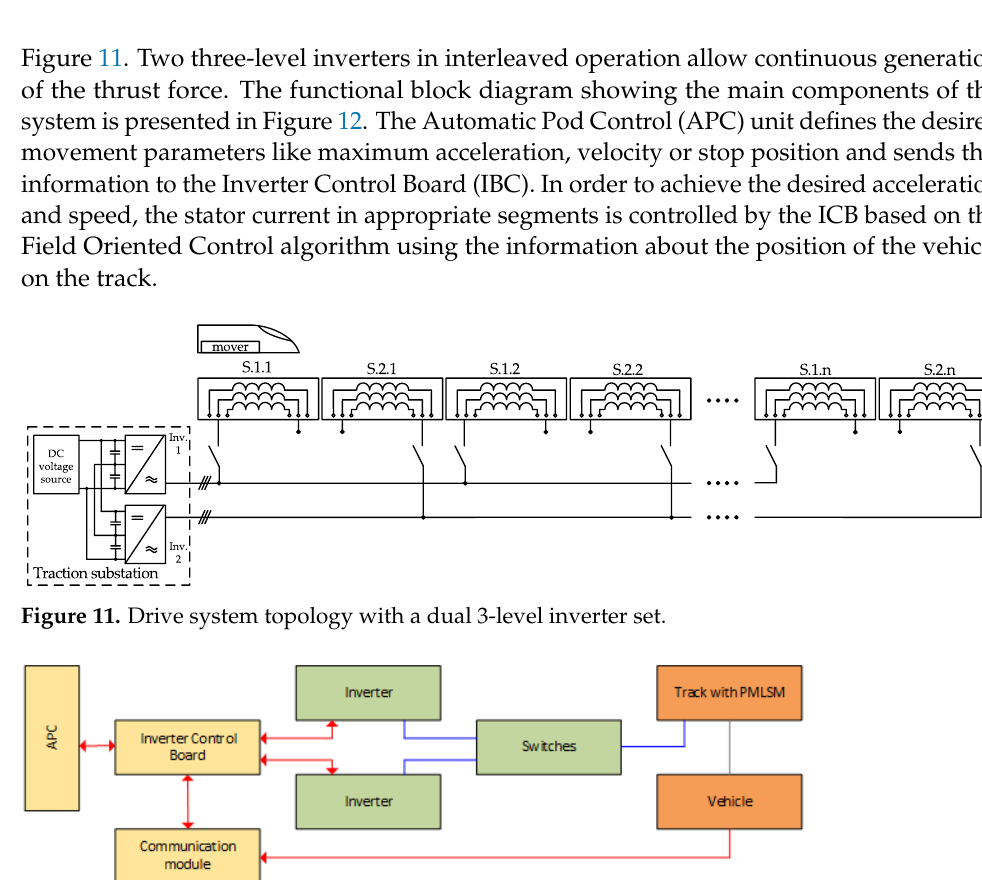
Figure 12. Functional block diagram of the drive